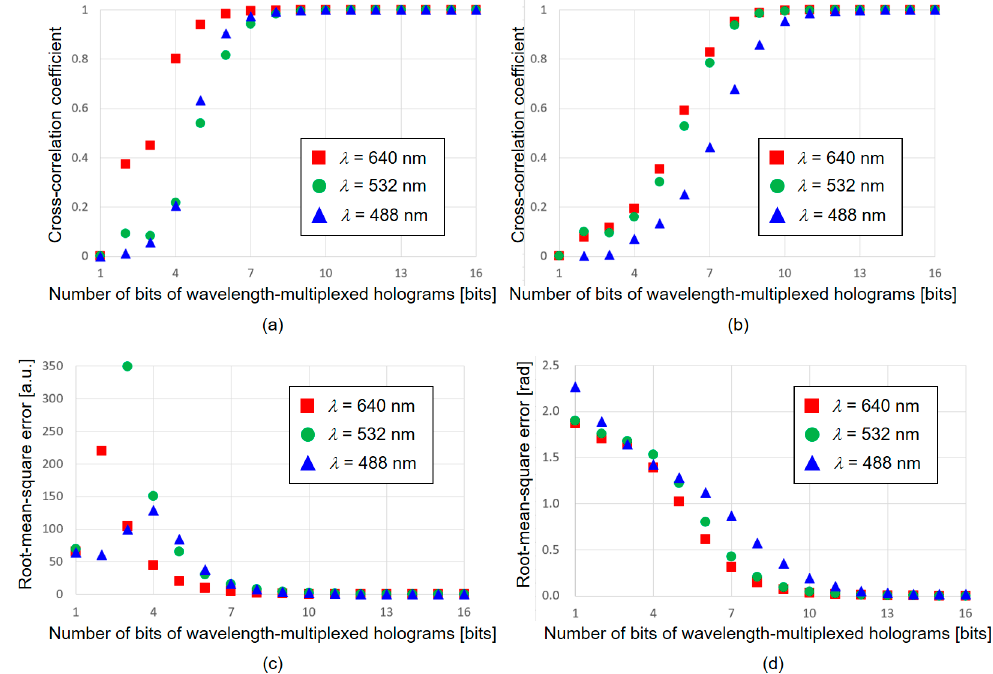
Figure 5. Quantitative evaluations for numerical results: CC of reconstructed ( a ) amplitude and ( b ) phase images and RMSE of reconstructed ( c ) amplitude and ( d ) phase images.